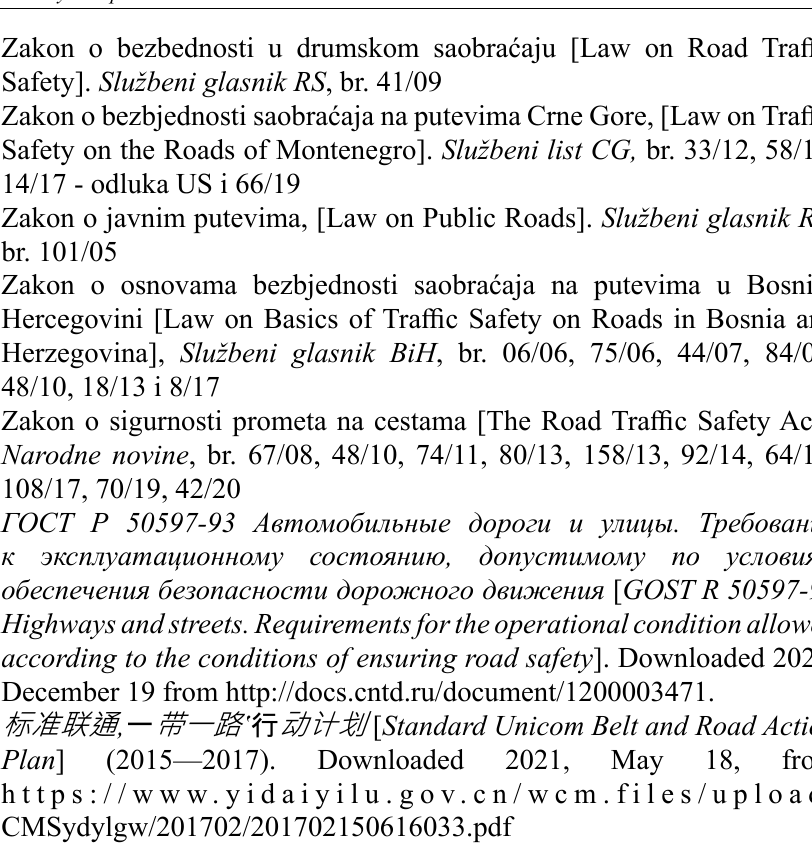
состоянию, допустимому по условиям обеспечения безопасности дорожного движения [ GOST R 50597-93 Highways and streets. Requirements for the operational condition allowed according to the conditions of ensuring road safety ]. Downloaded